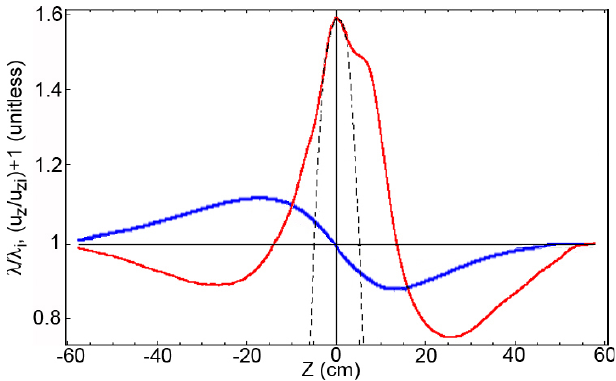
FIG. 6. (Color) Normalized line density (red) and axial velocity (blue) in the beam frame after most of the velocity tilt has been applied ( t (cid:8) 830 ns ). The center of the beam is located at Z (cid:8) (cid:2) 29 cm in the laboratory frame at this instant of time. The dashed line is the parabola 2 (cid:4) 1 (cid:1) z 2 = 36 (cid:5) , where z is in cm.